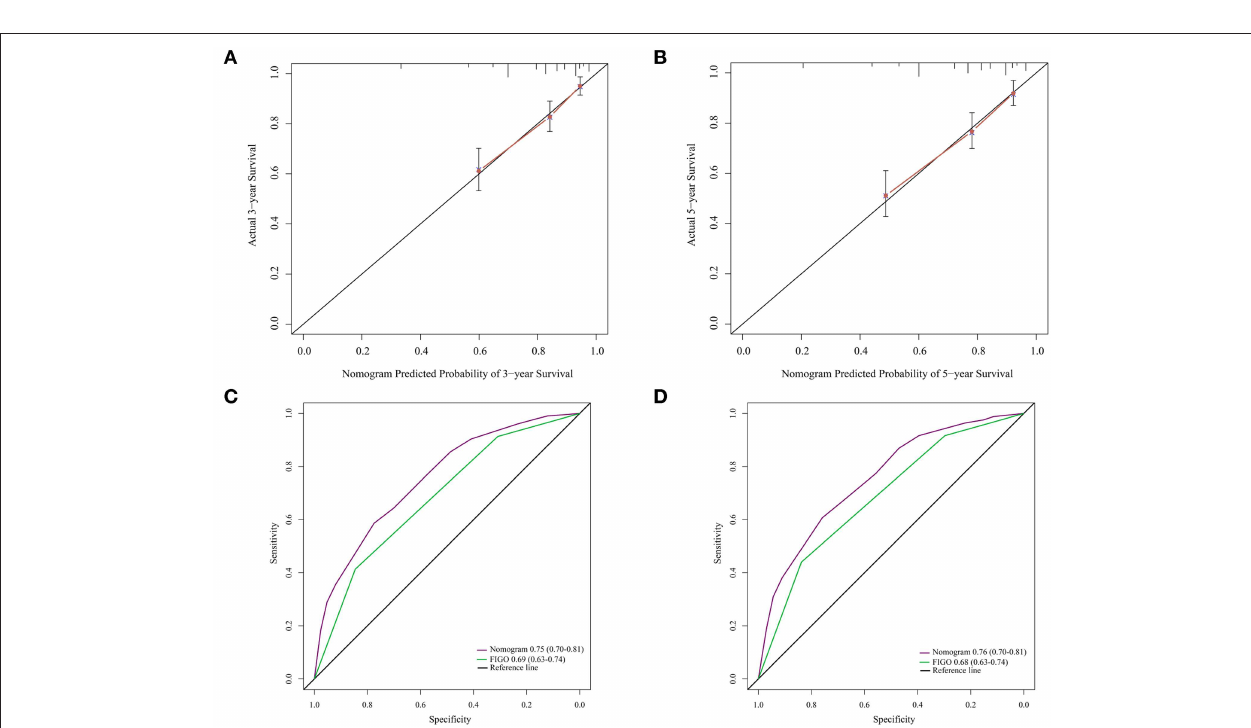
FIGURE 4 | (A) The 3-years survival rate of cervical cancer patients predicted by nomogram is highly consistent with the actual observed values. (B) The 5-years survival rate of cervical cancer patients predicted by nomogram is highly consistent with the actual observed values. (C) The ability of ROC analysis nomogram to predict the 3-years survival rate of the cervical cancer patients, the nomogram has a larger AUC than FIGO staging. (D) The ability of ROC analysis nomogram to predict the 5-years survival rate of the cervical cancer patients, the nomogram has a larger AUC than FIGO staging.